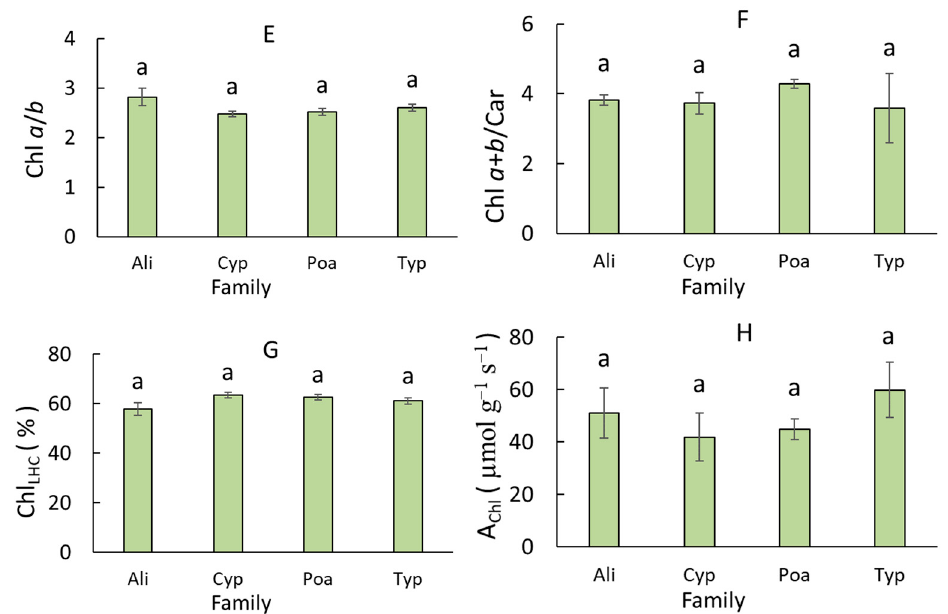
Figure 3. Leaf pigment complex traits in monocotyledonous wetland plants of different families (Ali, Alismataceae ; Cyp, Cyperaceae ; Poa, Poaceae ; Typ, Typhaceae ). ( A ) Chlorophyll and ( B ) carotenoid content per fresh weight. ( C ) Chlorophyll and ( D ) carotenoid content per dry weight. ( E ) Ratio of chlorophylls a and b . ( F ) Ratio of chlorophylls and carotenoids. ( G ) Proportion of chlorophyll in the light-harvesting complex. ( H ) CO 2 uptake rate per unit of chlorophyll weight. Different letters indicate significant differences between life forms ( p < 0.05). Error bars represent standard error (SE).